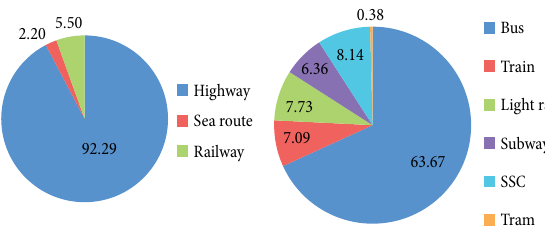
Fig. 1. Percentage utilization of transportation type and public transport in Istanbul (IETT